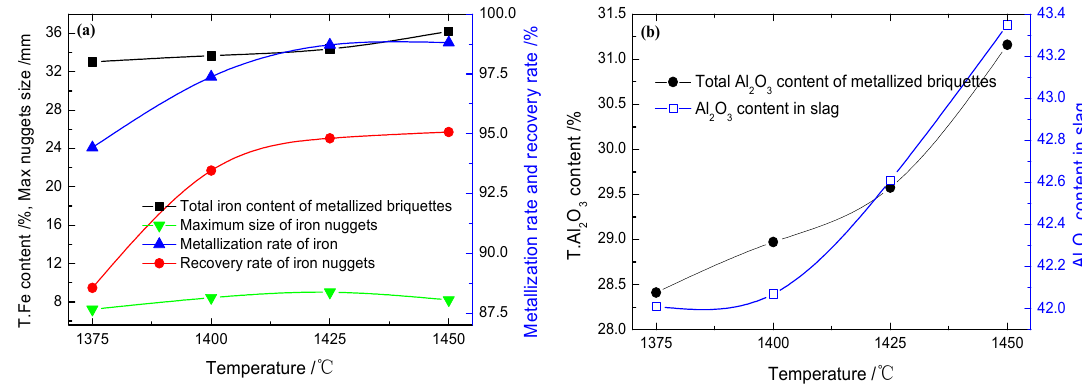
Figure 9. Effect of reduction temperature on ( a ) reduction indexes and ( b ) Al 2 O 3 grade.